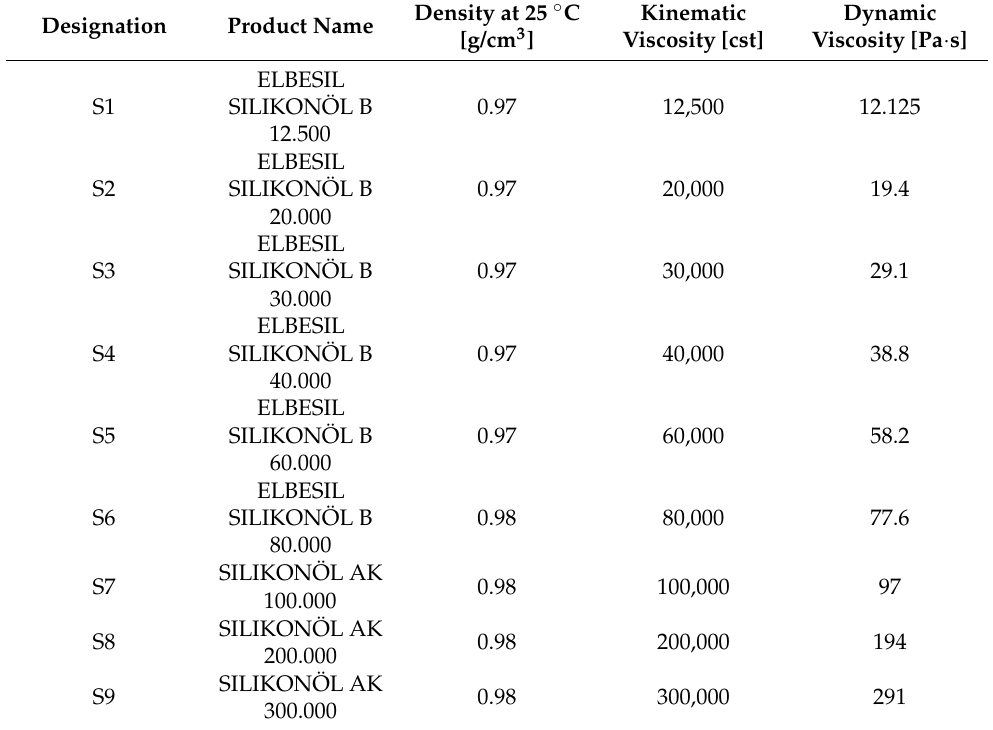
Table 1. Selected silicon oil types and resulting viscosity data for the simulation [23].